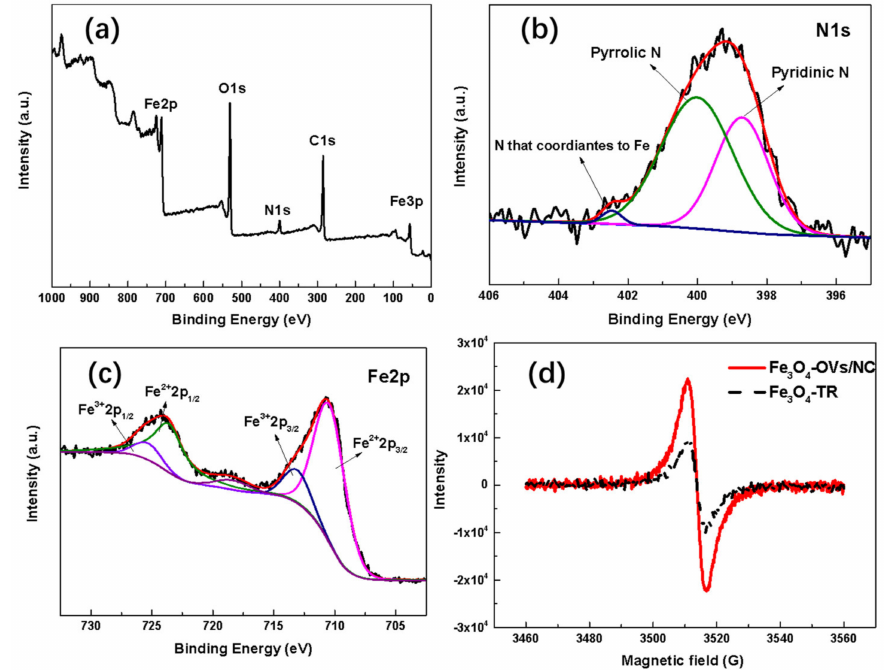
Figure 3. ( a ) XPS survey spectrum of Fe 3 O 4 -OVs/NC. High-resolution XPS spectra of ( b ) N 1s and ( c ) Fe 2p. ( d ) EPR spectra of Fe 3 O 4 -TR and Fe 3 O 4